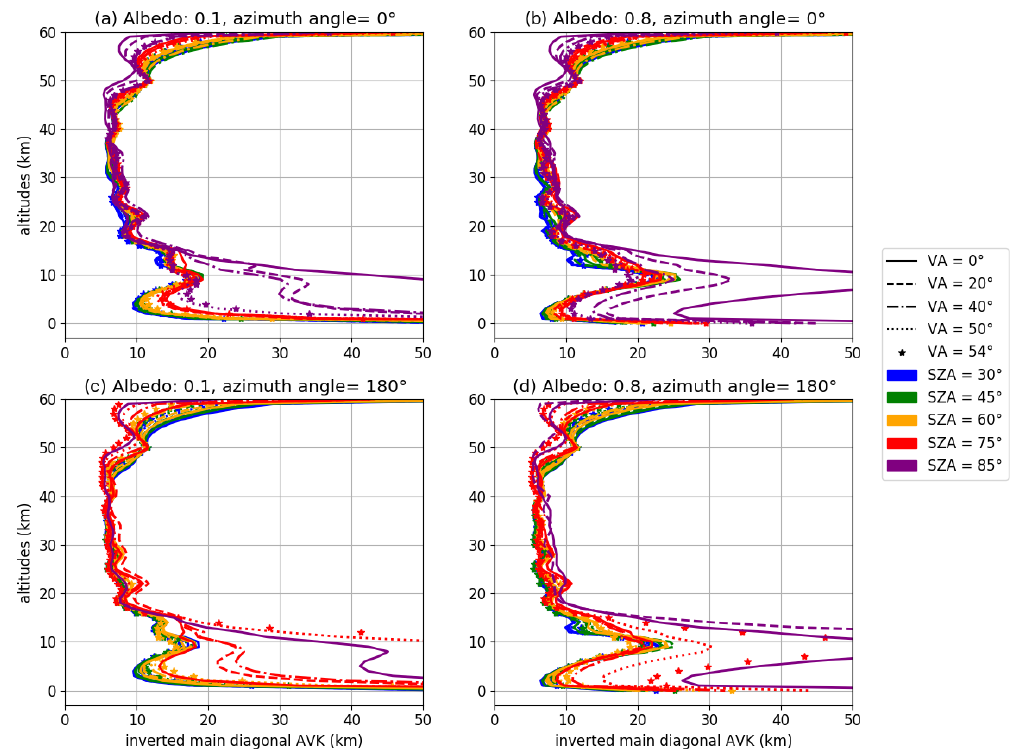
Figure 4. Vertical resolution of the retrieval for all simulations with the Chinese polluted ozone profile. The panels show the different combinations of the surface albedo (0.1 and 0.8) and relative azimuth angles (0 and 180 ◦ ). Each panel displays the results for 25 combinations of VA and